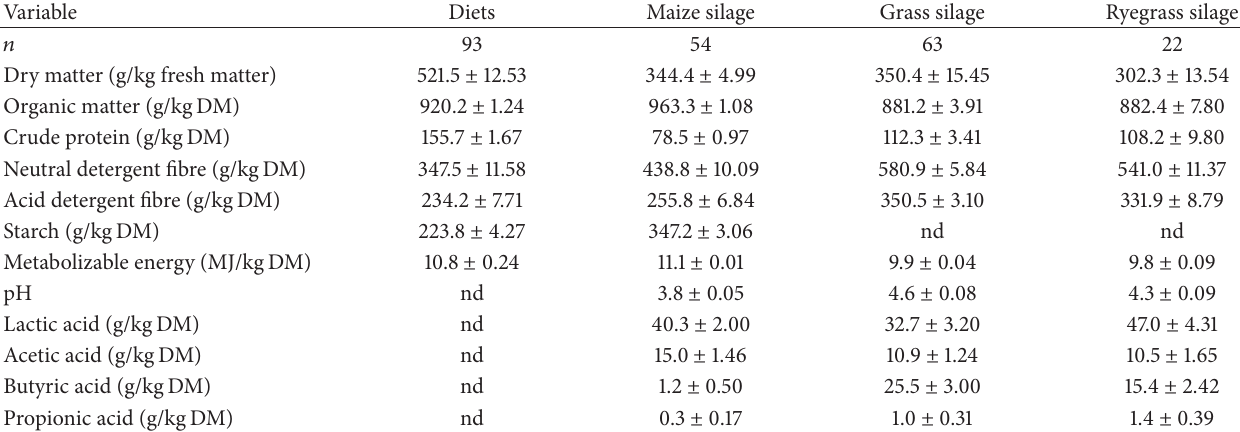
Table 1: Average chemical composition and standard deviation of diets and silages and fermentative characteristics of silages.